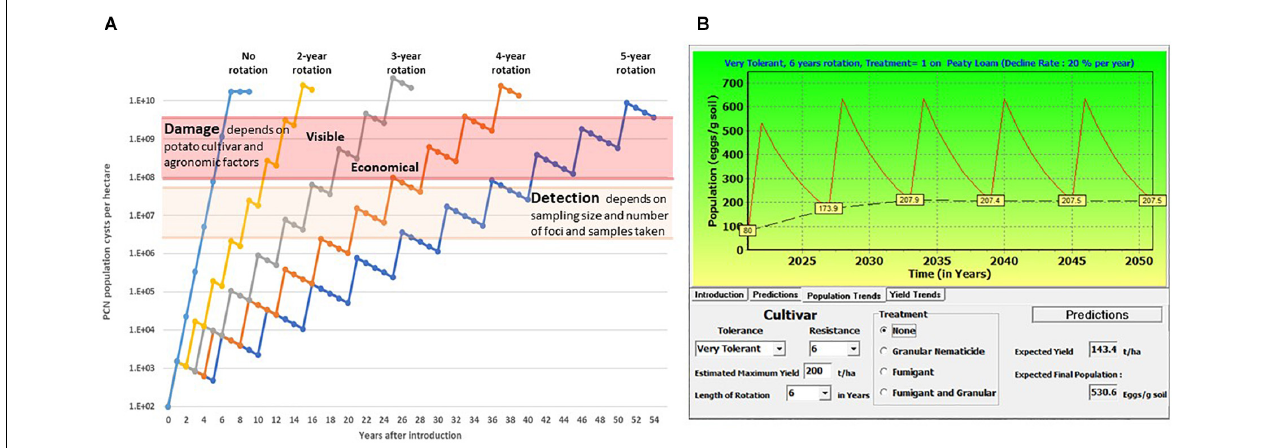
FIGURE 1 | (A) Schematic illustration of the increase of potato cyst nematodes (PCN) cysts with different rotation intervals, and the time until detection and damage thresholds are reached. This simplified sketch shows a natural decrease of viable cysts of 25% per year, and a 15-fold multiplication rate per year, no other factors are considered. (B) This illustrates the predictions of a model in which different factors including initial population level (in this example 80 eggs/g soil) soil type, nematicide treatment and rotation length, and cultivar characters including tolerance and resistance, can be altered to predict population and yield trends using a specified decline rate of 20%